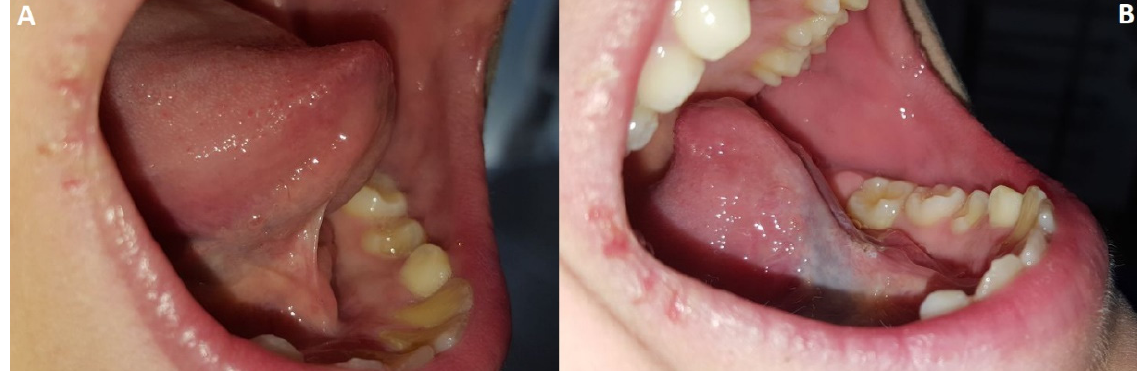
Figure 10. The mobility of the tongue is extremely limited before the operation ( A ) while it is visibly increased already in the immediate post-operative ( B ).